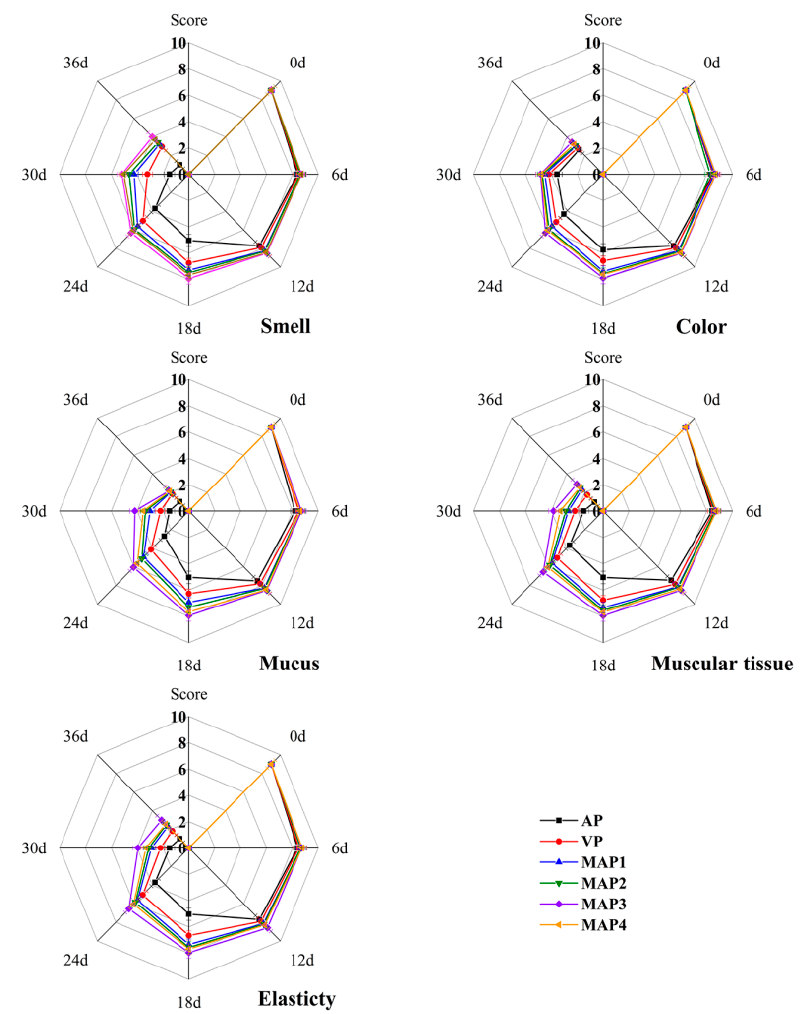
Figure 4. Changes in smell, color, mucus, muscular tissue, and elasticity of Chinese sea bass during superchilling storage at − 0.9 ◦ C. AP: air package; VP: vacuum package; MAP1: modified atmosphere packaging with 40% CO 2 / 60% N 2 ; MAP2: modified atmosphere packaging with 40% CO 2 / 10% O 2 / 30% N 2 ; MAP3: modified atmosphere packaging with 60% CO 2 / 10% O 2 / 30% N 2 ; MAP4: modified atmosphere packaging with 60% CO 2 / 40% N 2 .